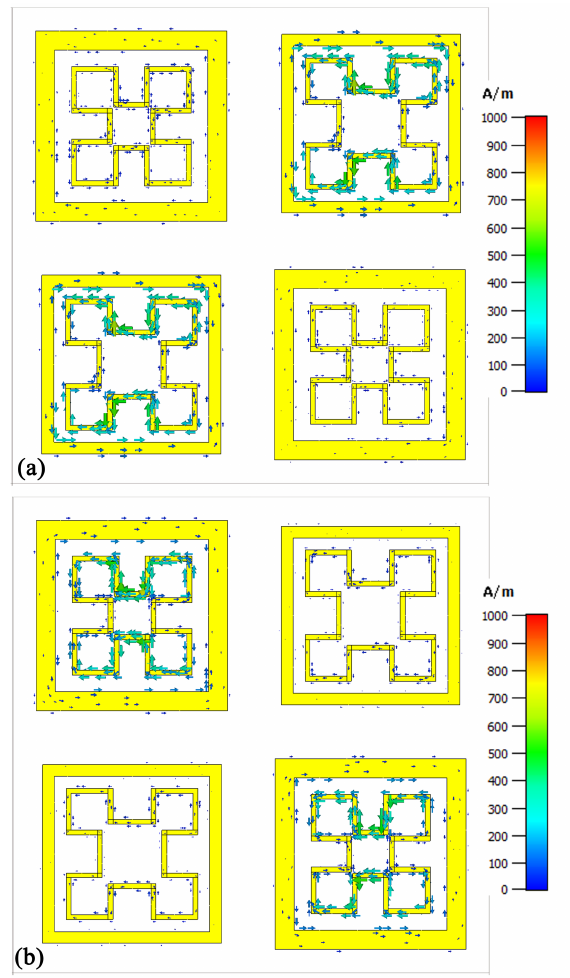
Figure 4: Surface current distributions of the dual-band EIT- like metamaterial at the EIT-like resonances of (a) 8.77 GHz and (b) 9.22